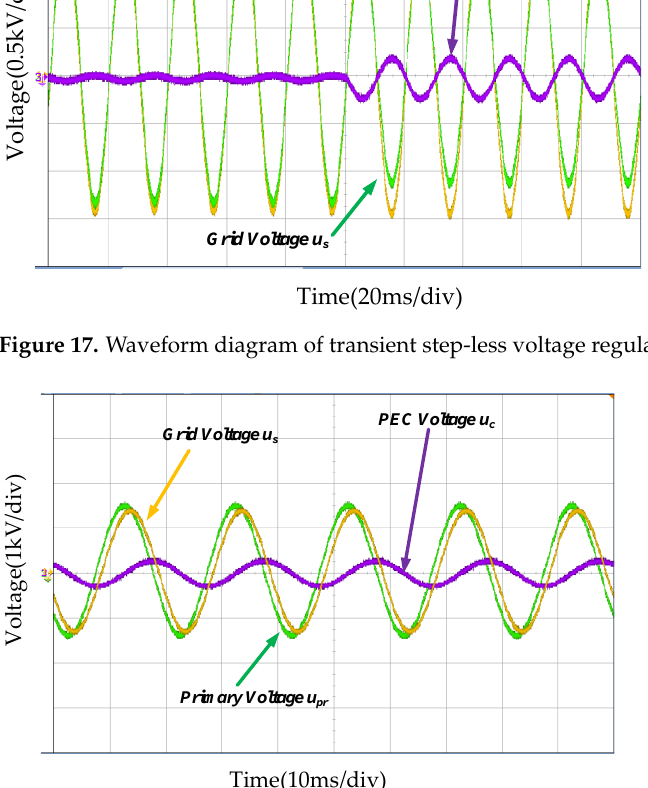
Figure 18. Waveforms of minimum vector reactive power compensation for flexible OLVR.